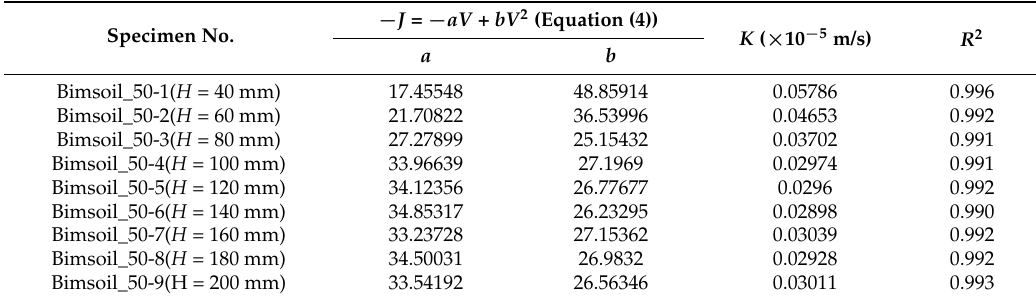
Table 5. The non-Darcy’s flow equations for typical specimens with rock block percentage of 50%, using Forchheimer equation.